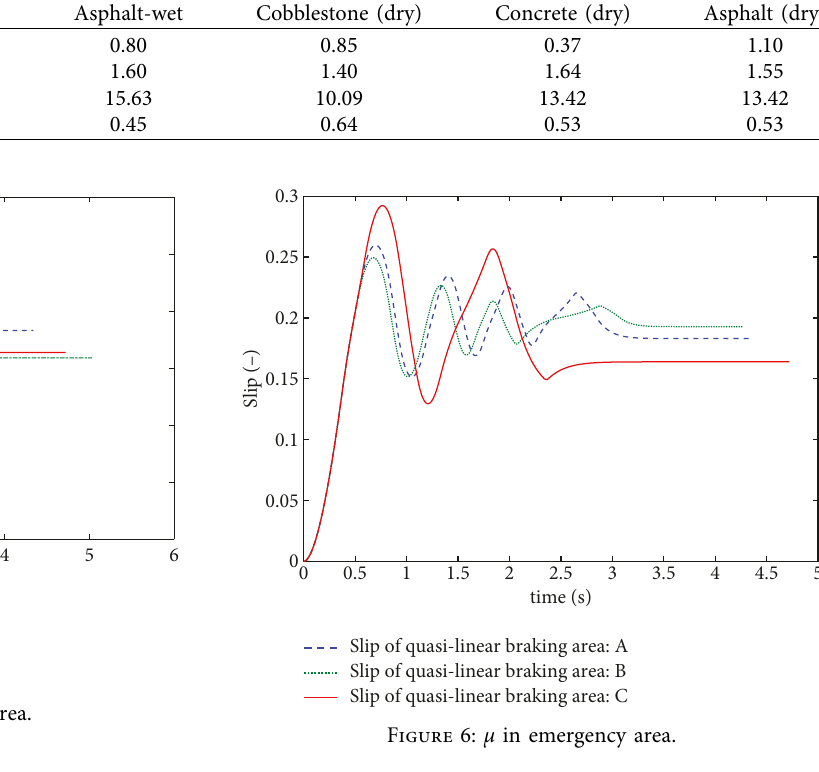
Figure 6: μ in emergency area.